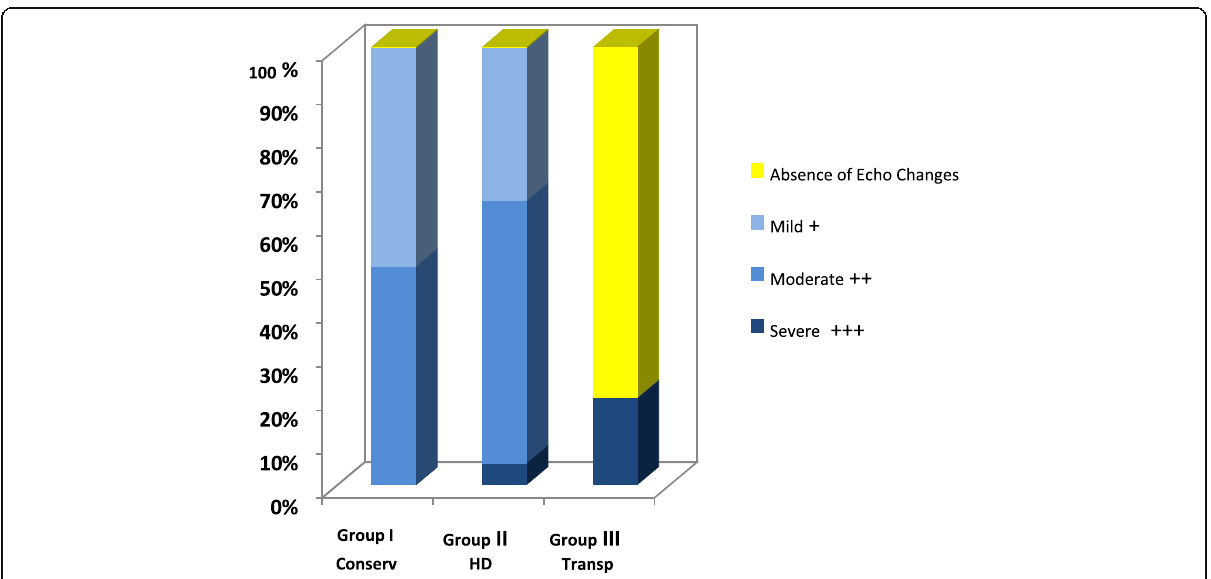
Fig. 2 Frequency distribution of cases according to echocardiography changes